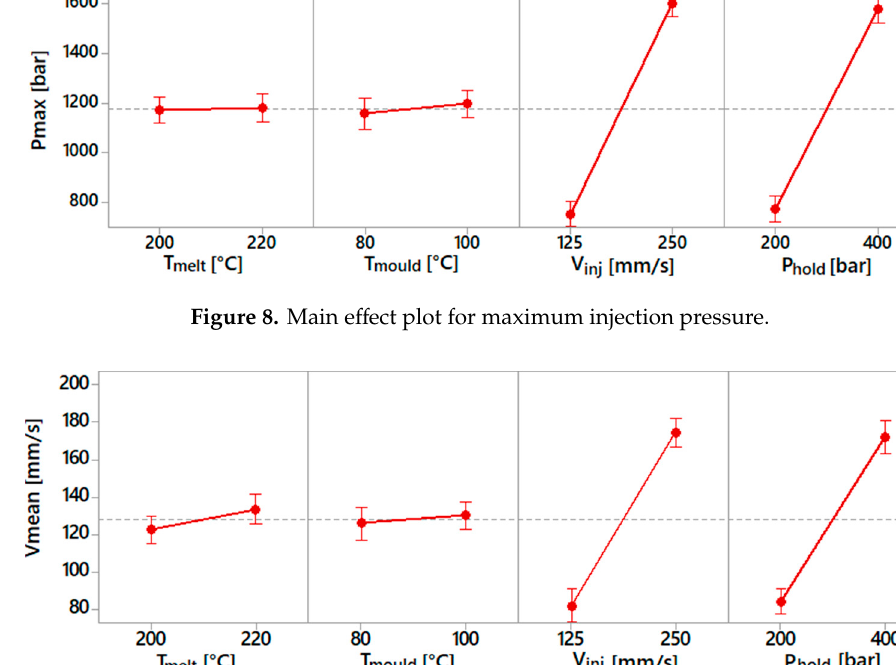
Figure 8. Main effect plot for maximum injection pressure.